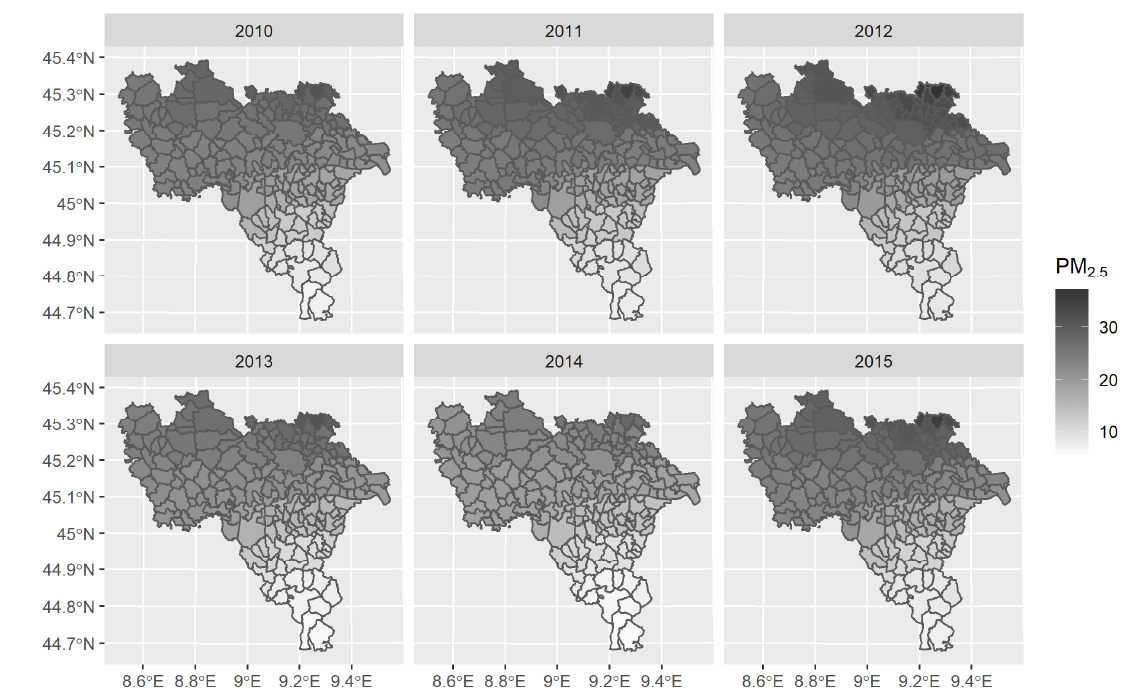
Figure 2. Spatio-temporal distribution of PM2.5 annual mean concentration ( µ g/m 3 ) for each municipality: higher concentrations of particulate matter are indicated with darker colours and smaller concentrations with light colours.